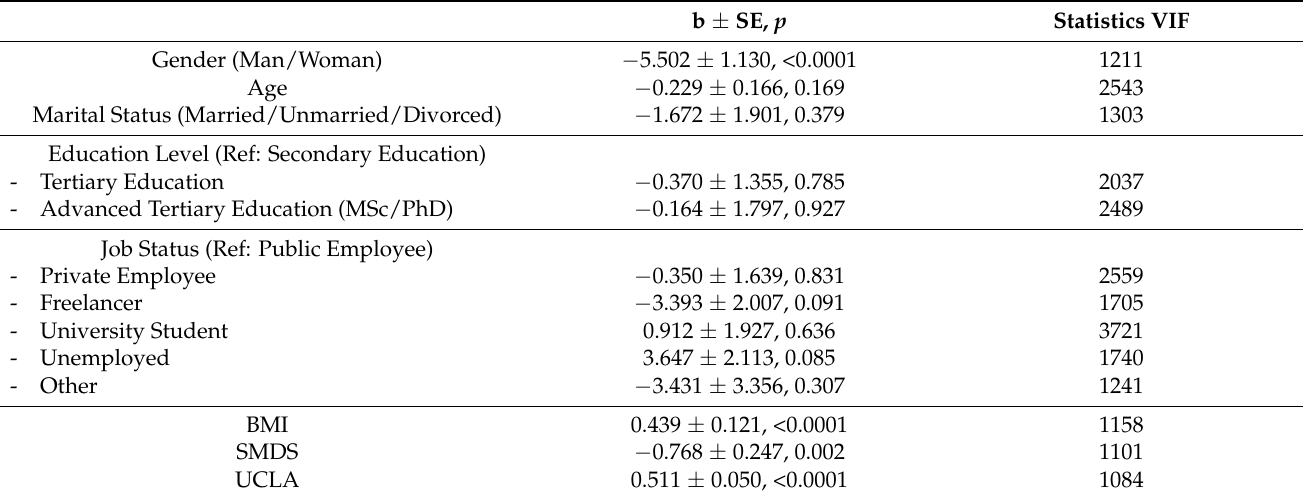
Table 4. Results (b, SE) from regression analysis models that evaluated various participant character- istics and measures as determinants of